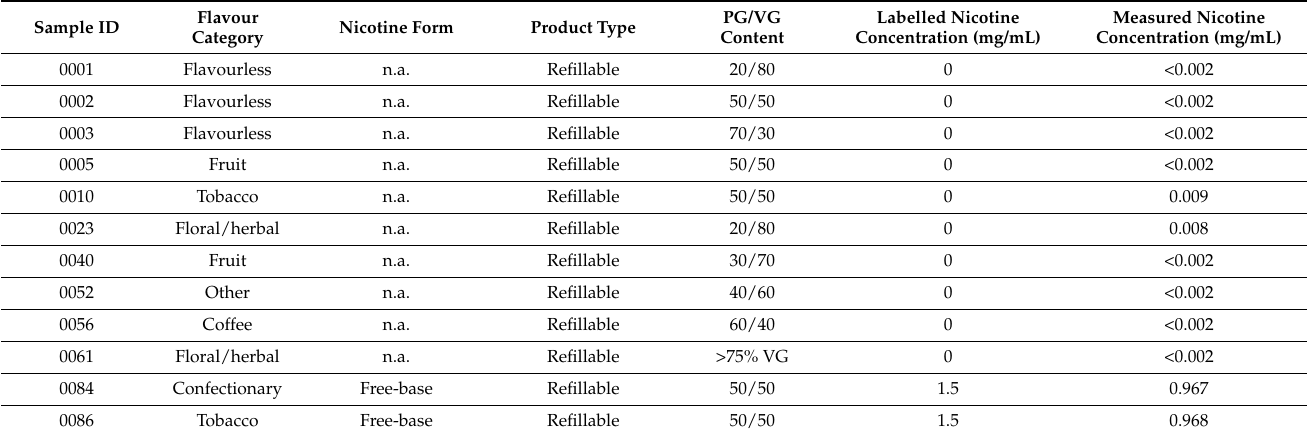
Table 2. Nicotine-free or low-nicotine vaping liquids analyzed, (N =